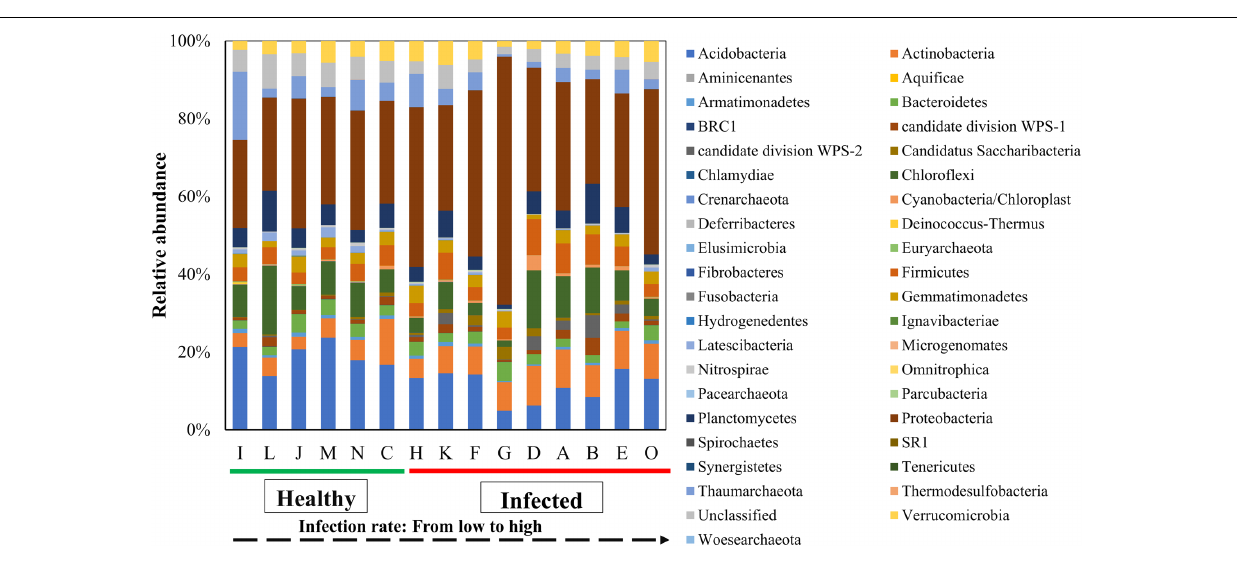
(Pearson = − 0.641, p = 0.010). As we focused on the